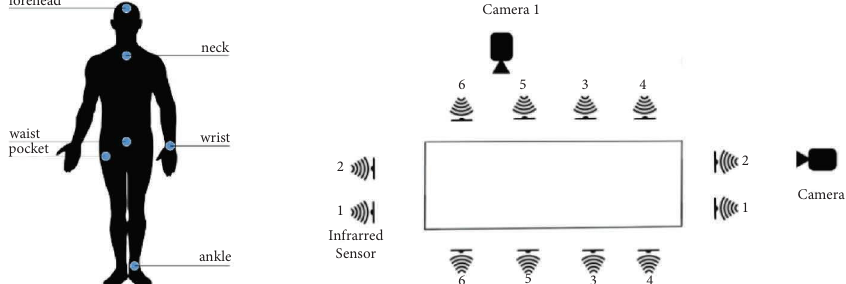
Figure 2: Wearable sensor devices, ambient sensor, and camera device distribution.